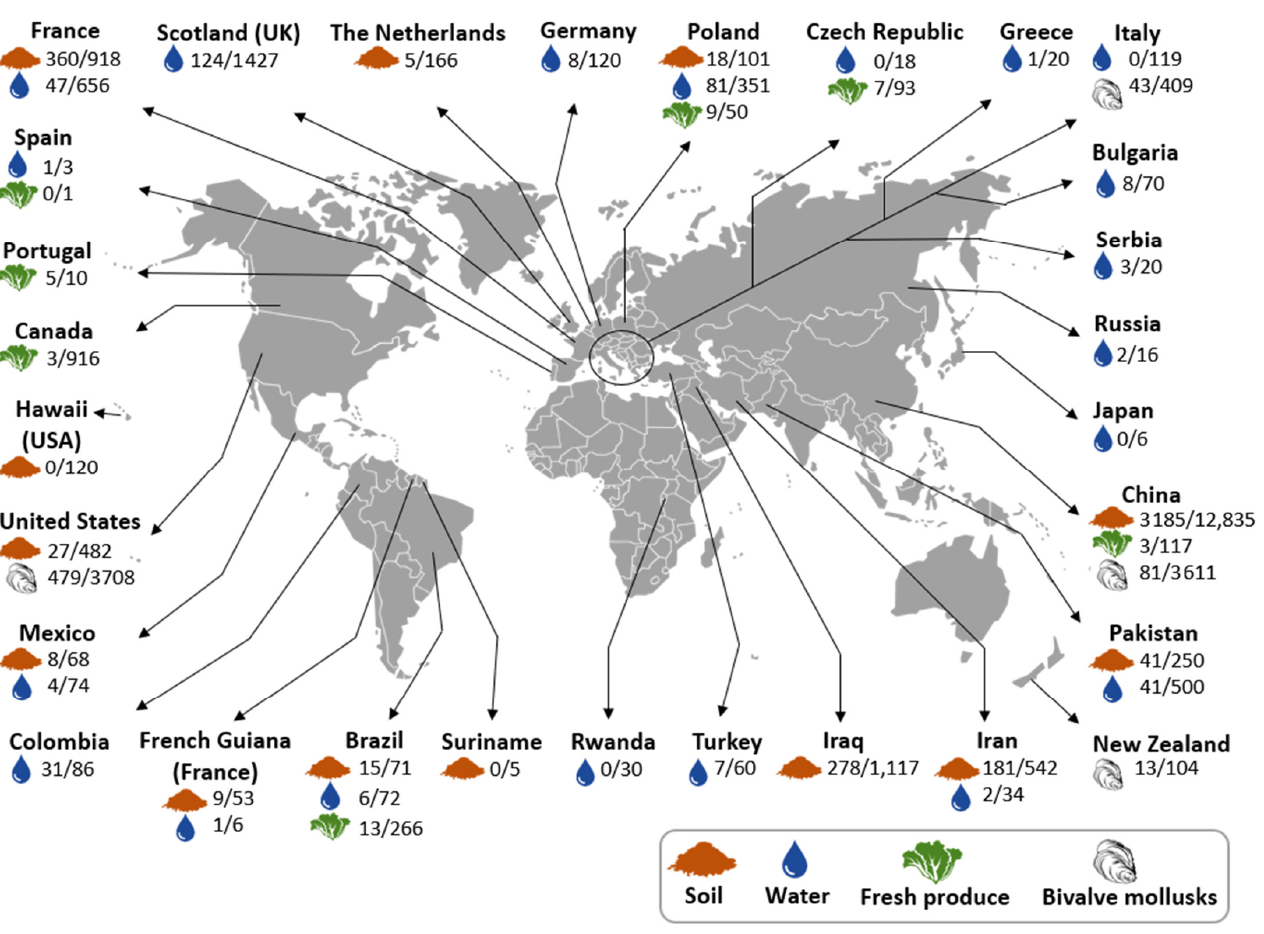
Figure 2. Worldwide detection of Toxoplasma gondii oocysts in environmental matrices based on molecular methods (PCR, qPCR, and LAMP) in studies published by the end of 2020. Results are presented as positive samples/total of samples collected. Articles that analyzed pooled samples and did not specify how the number of positive individual samples was estimated were excluded.